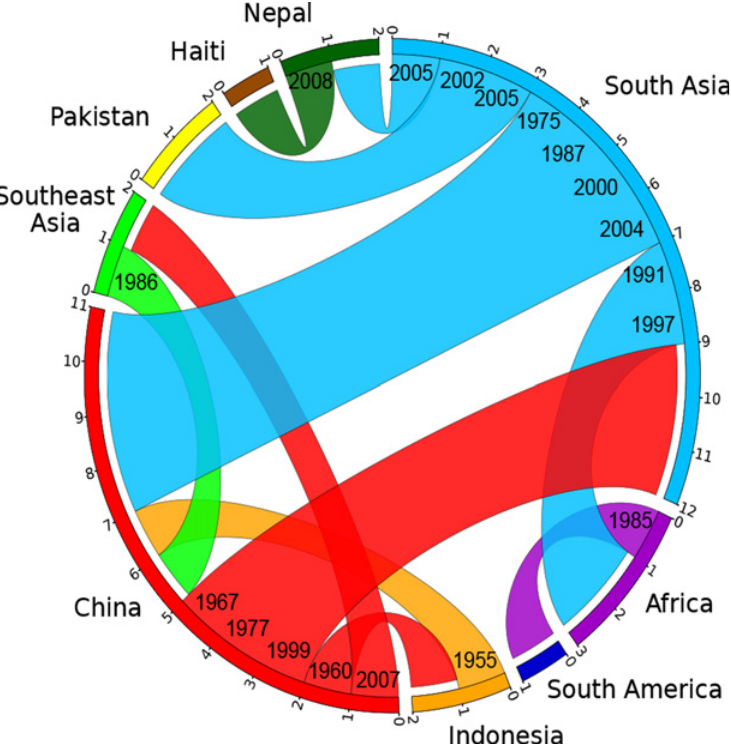
Fig 4. Circular plot illustrating the inferred migrations between geographical locations. Flow bars indicate the sources of transmissions, colored as in Fig. 3, with one end of the bar directly touching the country of origin, and the other end of the bar having a small gap before the country of destination. The average date for each migration is shown on the ends corresponding to the